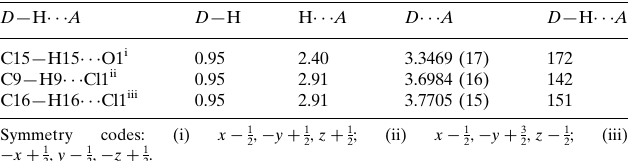
Hydrogen-bond geometry (A˚ , (cid:1)